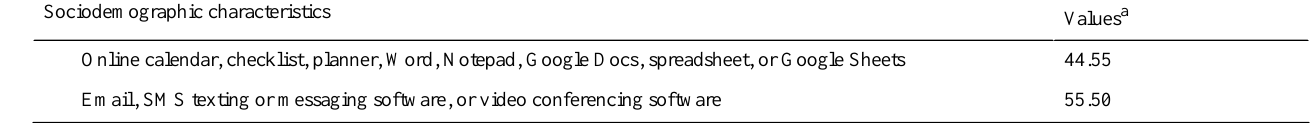
Table 2. Association between symptoms indicative of clinical levels of depression and anxiety and rates of COVID-19 cases and time: estimates based on two separate logistic models (N=5899) a .